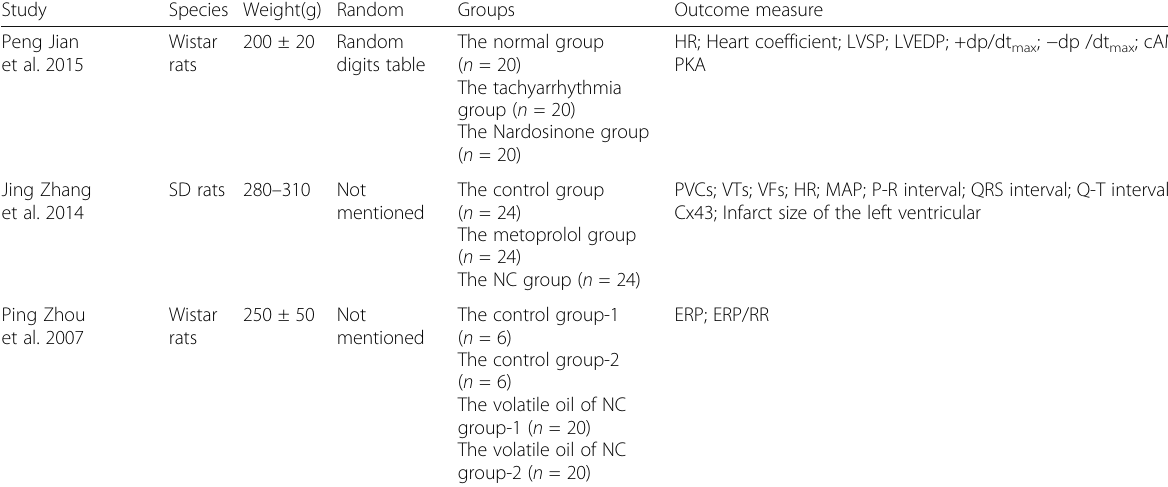
Table 6 The detailed information of the animal experiment Study Species Weight(g) Random